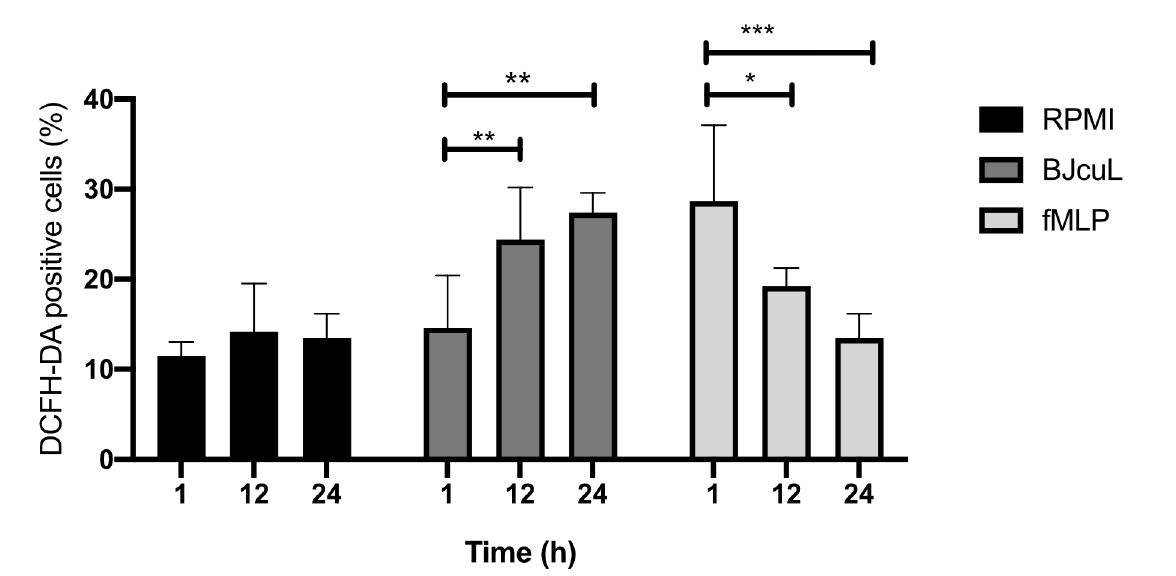
Figure 5. Determination of neutrophil intracellular hydrogen peroxide production. Neutrophils were treated with BJcuL (2.5 µg/mL) or fMLP (10 µM) for 1, 12, and 24 h and stained with DCFH-DA for flow cytometric analysis. Results are represented as mean ± SD. Statistical analysis was done using ANOVA and Dunnett’s test for comparison of treated groups with untreated control (RPMI). Statistical significance is represented as *p < 0.05, and ***p <